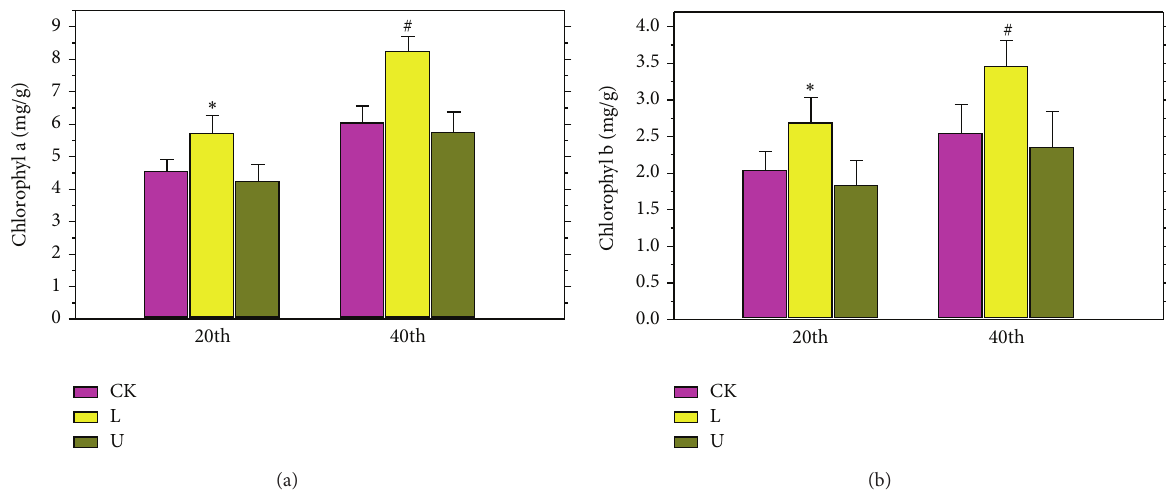
Figure 1: Effects of red LED and UV-B on the chl a (a) and chl b (b) of the mung bean. CK in figure refers to use ordinary fluorescent light as treat light sources. L in the figure refers to using both ordinary fluorescent light and red LEDs. U in the figure refers to using both ordinary fluorescent light and UV-B radiation light. Data are means and SE of six replicate plants. Error bars represent standard errors. Means with different letters above bars were significantly different at the 𝑃 < 0.05 level ( 𝑛 = 6 ) according to Duncan’s multiple range test ( ∗ 𝑃 < 0.05 ; # 𝑃 < 0.05 ).